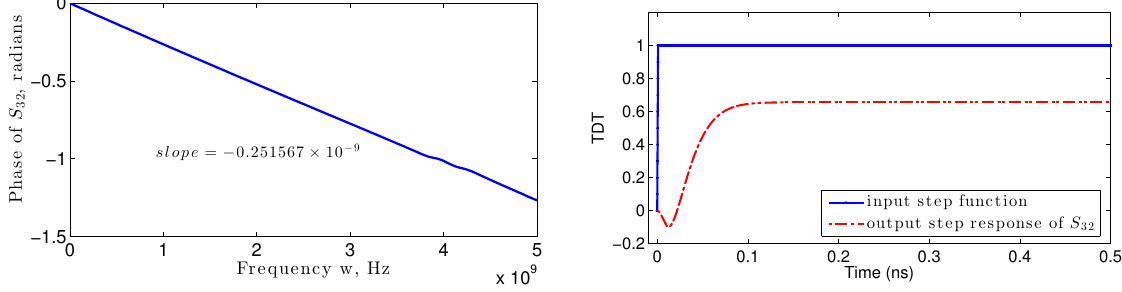
Figure 21. Left panel: phase of S as a function of frequency in the DDR4 module with 32 a DRAM package example. Its slope is − 0 . 251567 × 10 − 9 , which gives an approximation = 0 . 251567 × 10 − 9 / (2 π ) ≈ 0 . 04004 of the time delay T 0